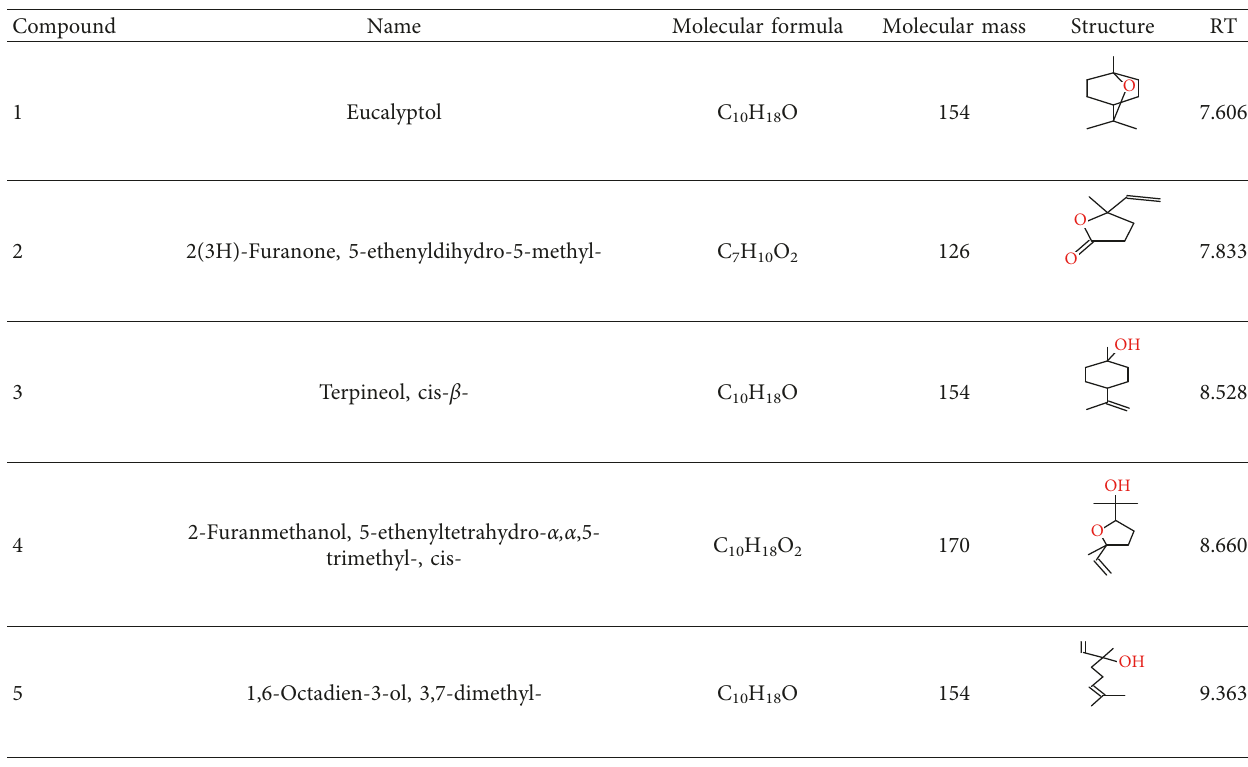
Table 2: Molecular formula, molecular mass, structure, and RTof compounds 1–5 of whole plant n -hexane fraction of Achillea wilhelmsii (WHFAW).